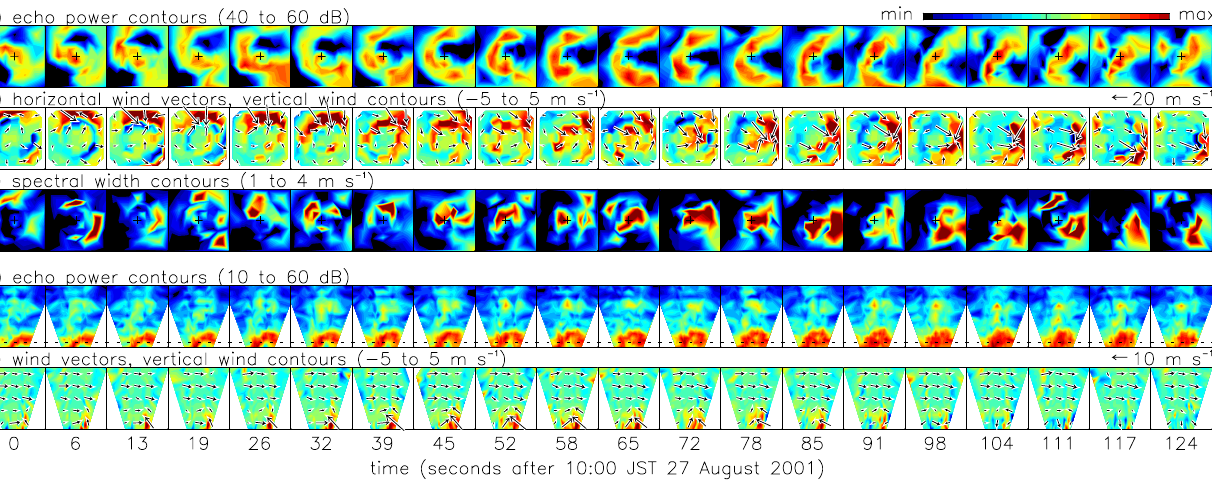
Fig. 7. ( a - c ) horizontal and (d, e) vertical SW–NE slices of data in Fig. 6. Plots are (a, d) echo power, (b, e) vertical-wind contours with horizontal-wind vectors overplotted, (c) spectral width. Vertical slices are 2km across and 1.275–3.275km AGL, horizontal slices are 700 × 700m. Dotted line in d) shows the height of horizontal slices (a–c). Vertical component of wind vectors in (e) is multiplied × 3 for